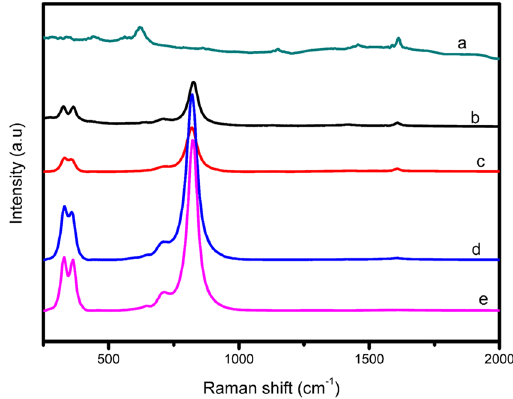
Figure 5. Raman spectra of ( a ) MIL-125(Ti), ( b ) 1–1 Bi:Ti ( c ) 2–3 Bi:Ti, ( d ) 3-2 Bi:Ti and ( e ) BiVO 4 .